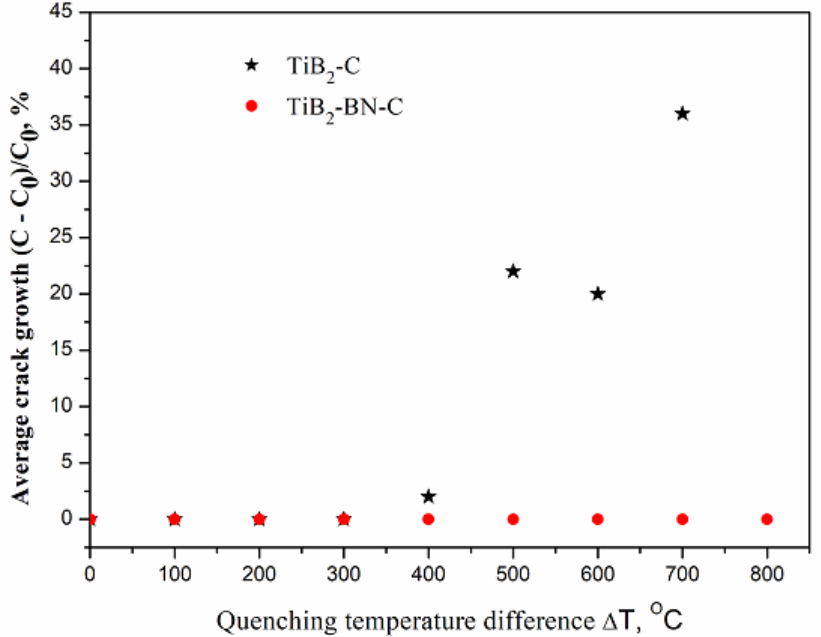
Figure 9. The dependence of the indentation crack growth after quenching from different tempera- tures of TiB 2 -C (asterisk, [12]) and TiB 2 -BN-C (this work, circles) samples. Comparison of the dynamic impact test results also showed the TiB 2 -BN-C material is less susceptible to mechanical failure compared to the TiB 2 -C counterpart and does not have cracks and damaging zones along the impact cavity edges (Figure 10).